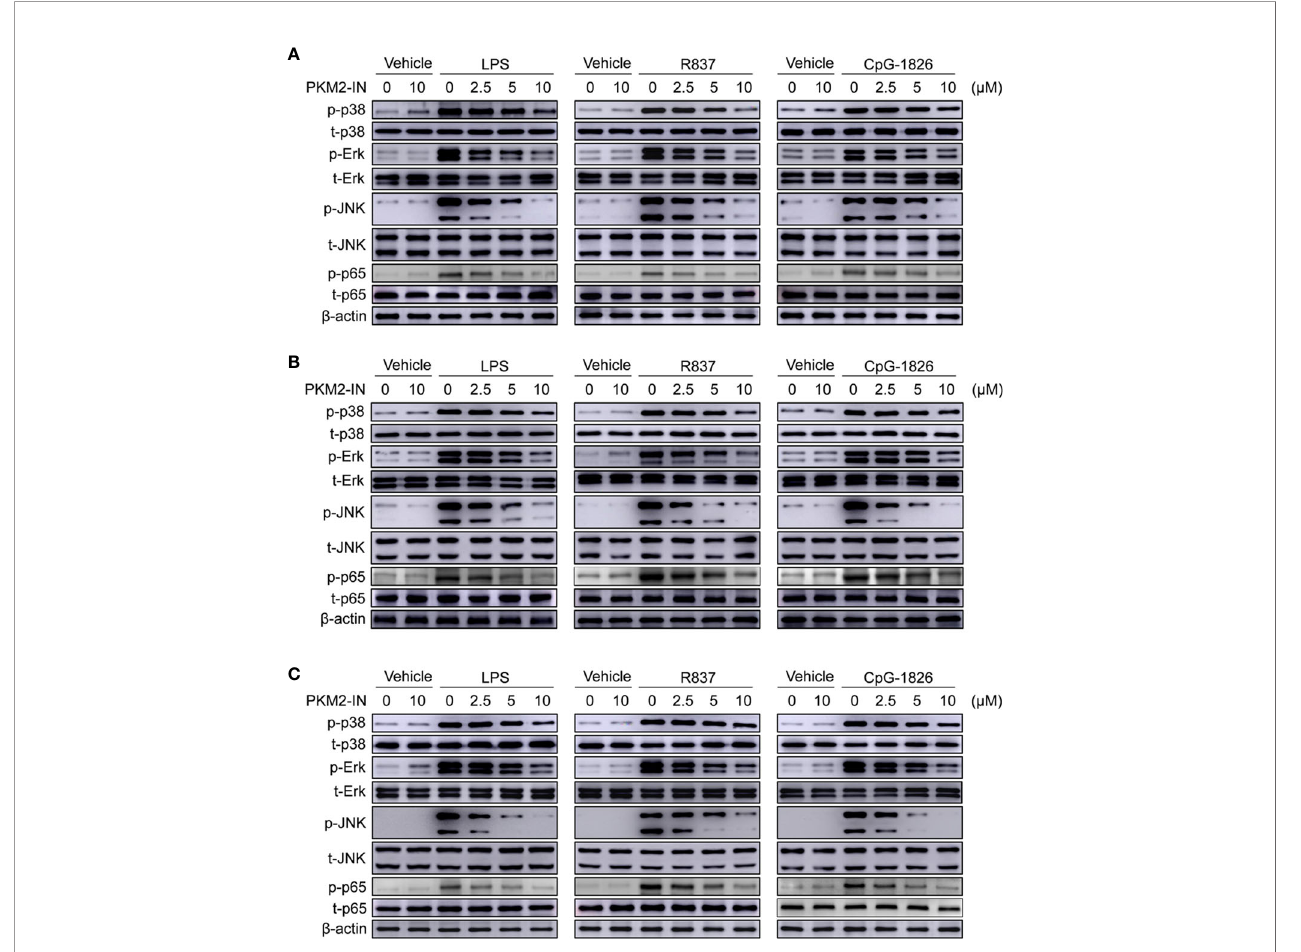
FIGURE 4 | Pharmaceutical inhibition of PKM2 inhibits TLRs-induced activations of MAPKs and NF- k B pathways in BMDMs, BMDCs and murine splenic B cells. BMDMs, BMDCs and murine splenic B cells were pretreated with PKM2 inhibitor PKM2-IN (2.5, 5 and 10 m M) for 2 hours followed by stimulations of LPS (100 ng/ mL), R848 (1 m g/mL) and CpG-1826 (1 m M). Western blot analysis of the phosphorylation levels of p38, Erk, JNK, and p65 in BMDMs (A) , BMDCs (B) and murine splenic B cells (C) at 1 hour. Data shown are representative of three independent